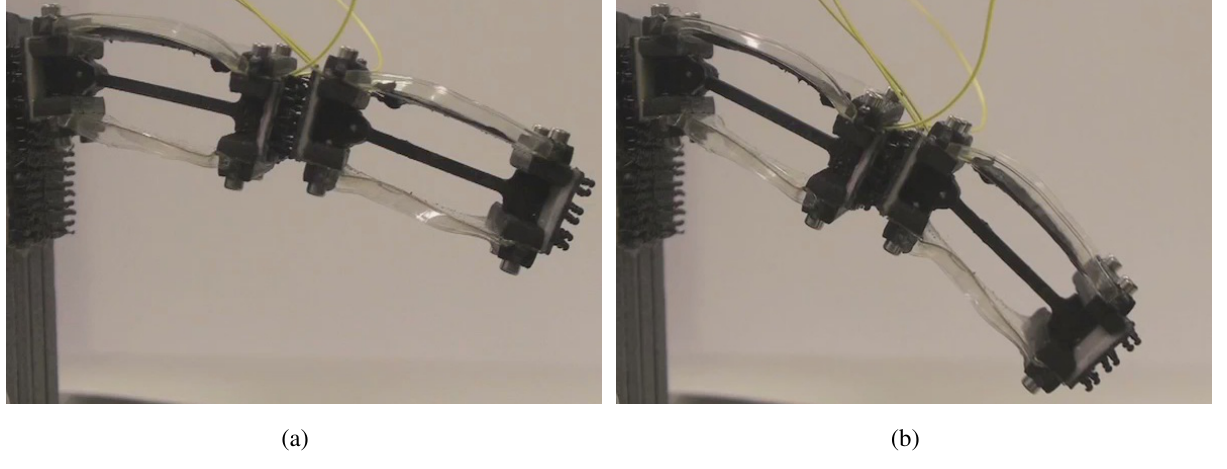
Figure 9. Two module configuration, each with the rotation axis perpendicular to gravity at 0 V ( a ) and 3,500 V ( b ).